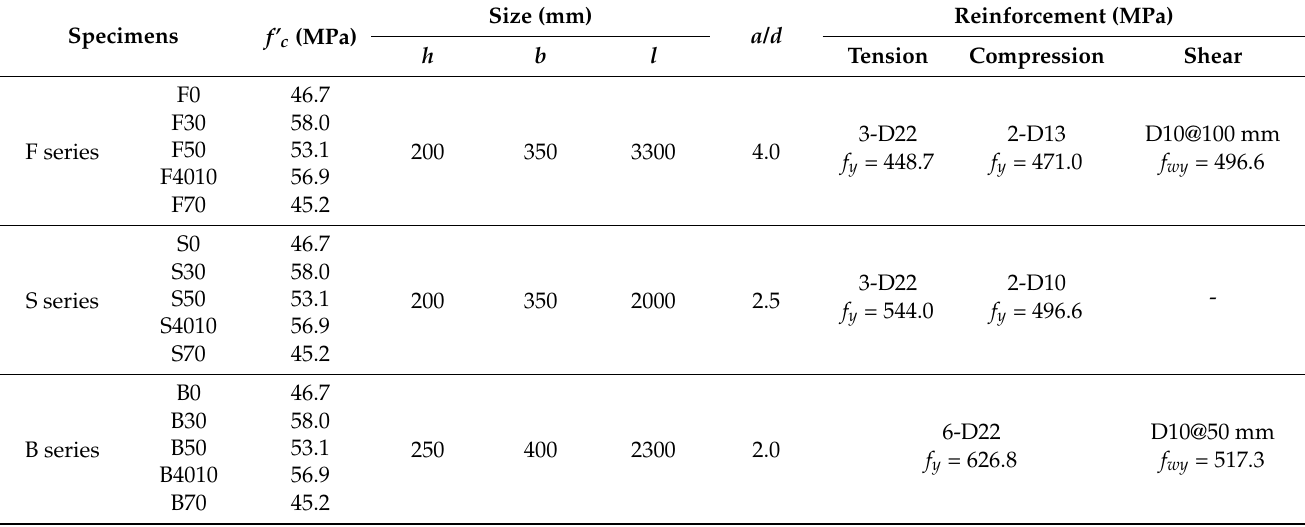
Table 2. Properties of